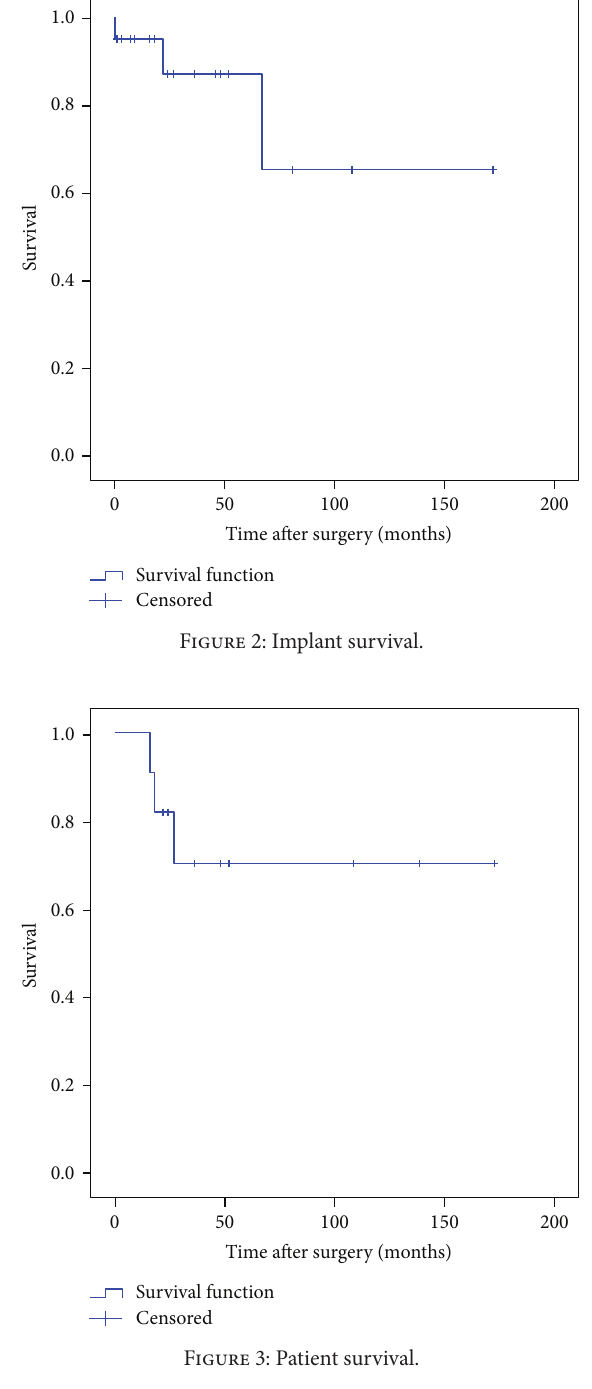
Figure 3: Patient